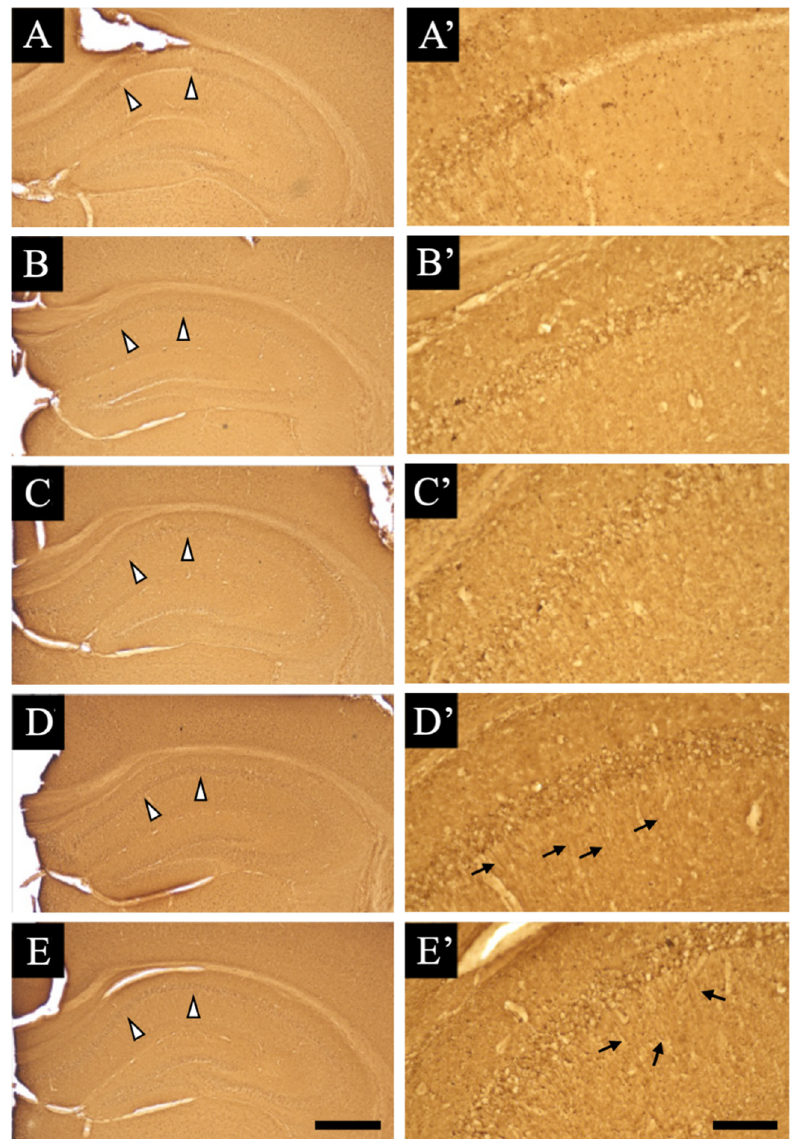
Figure 6. M1 muscarinic acetylcholine receptors staining sections are shown: ( A – E ) show the lower magnification views, ( A’ – E’ ) show the higher magnification views. ( A – E ) indicate the M1 muscarinic acetylcholine receptor-stained hippocampal sections of the vehicle-treated animals ( A , A’ ), piracetam- treated animals ( B , B’ ), aniracetam-treated animals ( C , C’ ), piracetam and α -GPC-treated animals ( D , D’ ), and aniracetam and α -GPC-treated animals ( E , E’ ). White arrowheads in ( A – E ) indicate the CA1 region. Black arrows in ( D’ , E’ ) show the M1 muscarinic acetylcholine receptors around the dendrites and/or axons of CA1 neurons. Scale bars in ( E , E’ ) = 500 µ m and 100 µ m,